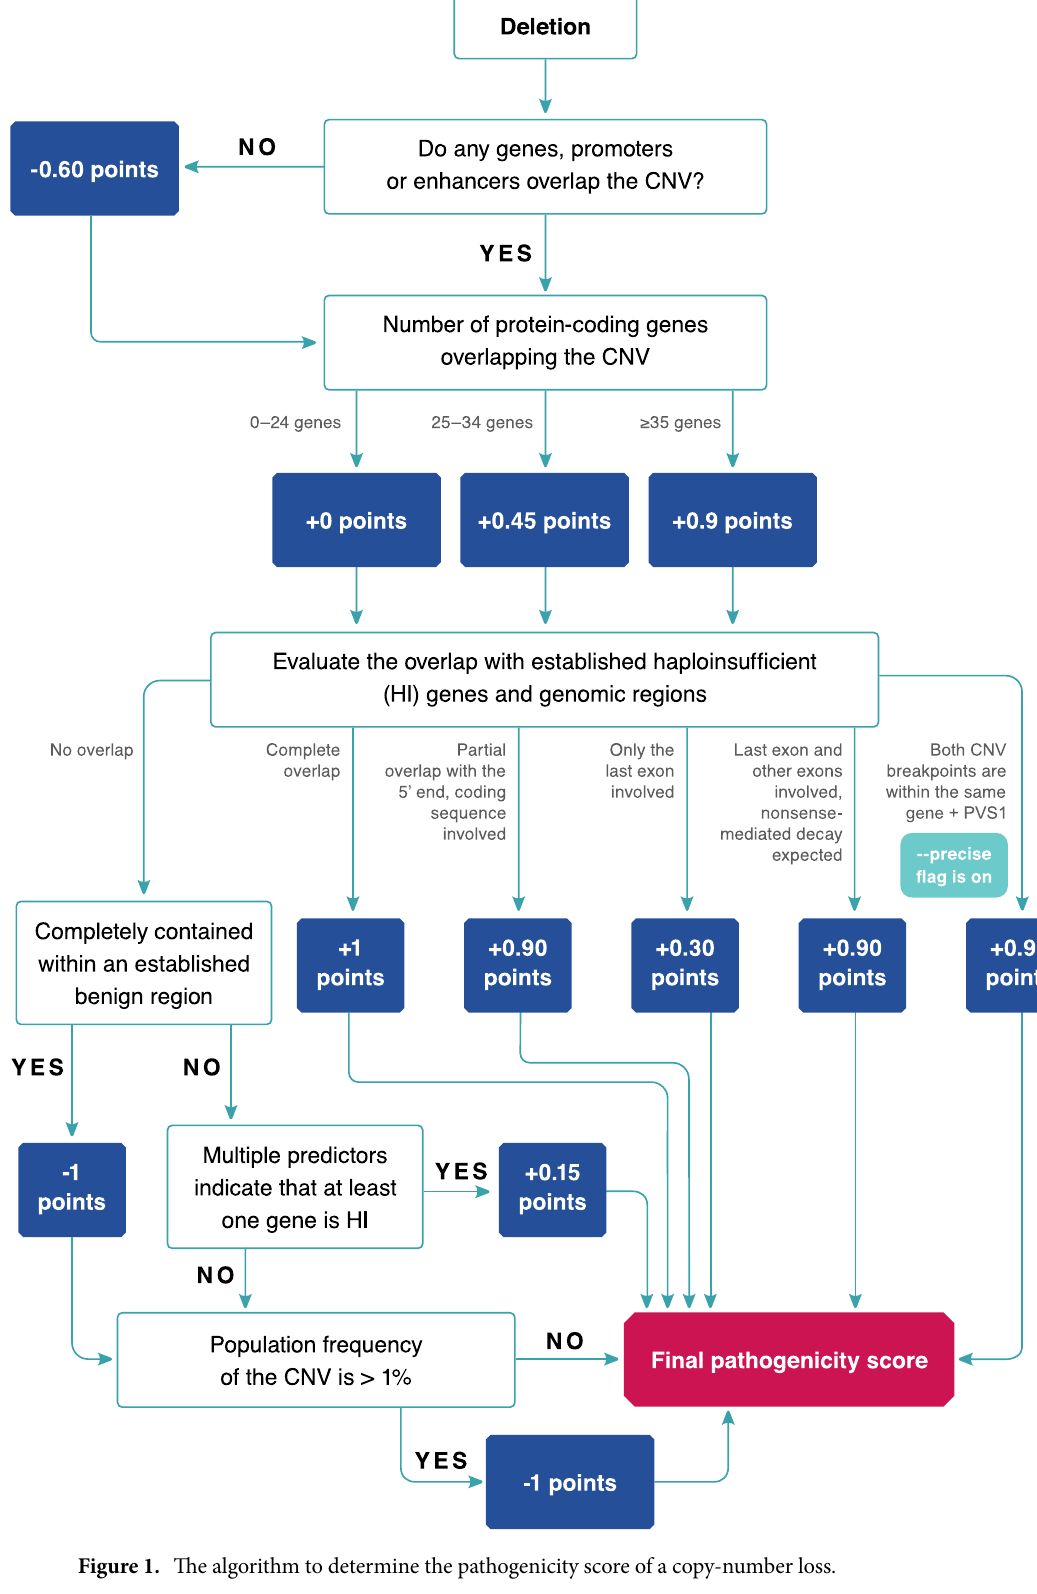
Figure 1. The algorithm to determine the pathogenicity score of a copy-number